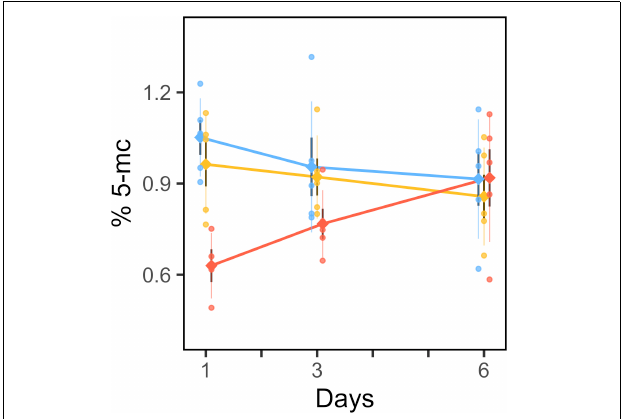
FIGURE 2 | Differential methylation of the Limacina helicina antarctica genome during acute exposure to future p CO 2 extremes. Mean values (diamonds) and individual replicates (circles) of percent 5-methylcytosine quantified using ELISA-based methods are plotted for 255 µ atm (blue), 530 µ atm (yellow), and 918 µ atm (red) p CO 2 treatments level across time. ± SE is represented by wide, black error bars. ± SD is represented by narrow, colored error bars.